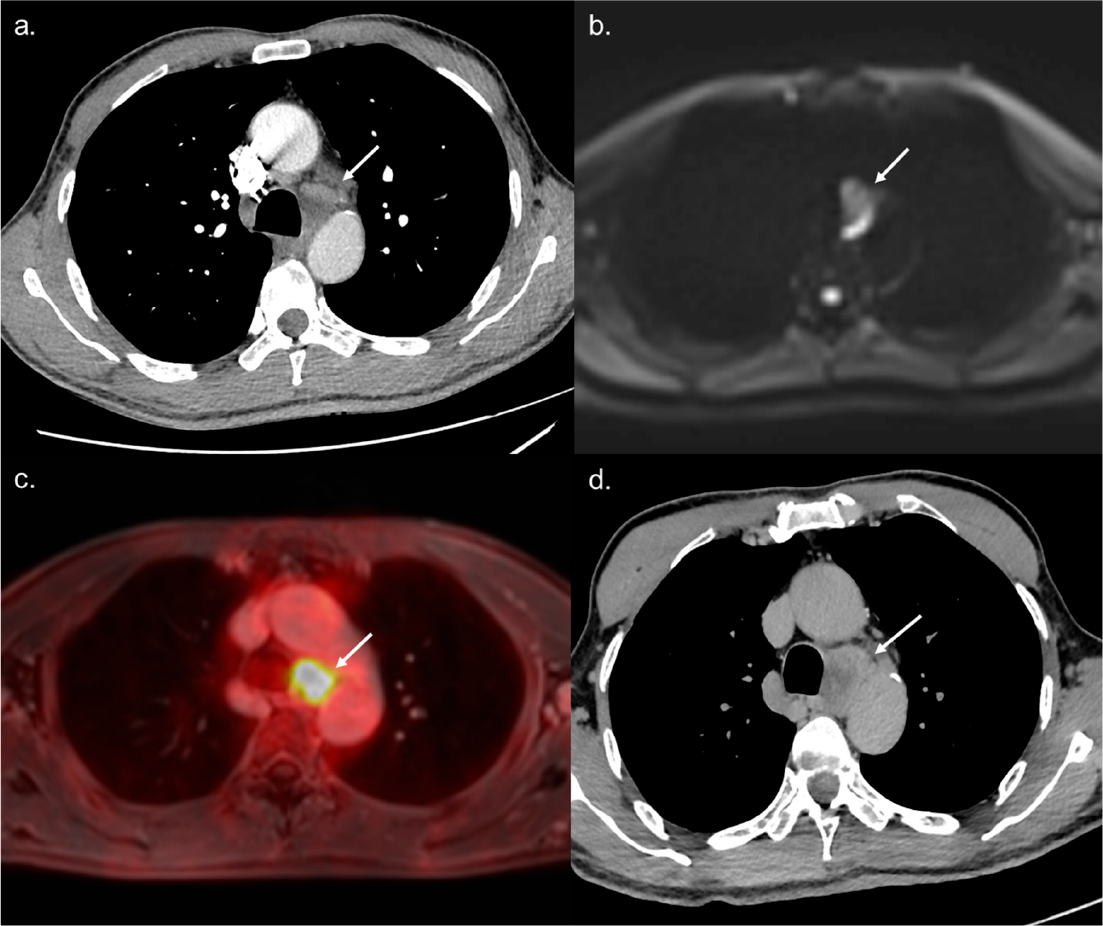
Figure 4. A 68-year-old BCLC C patient referred to WB-PET/MRI before TARE. The CT-CAP performed ( a ) showed a 12 × 25 mm large mediastinal lymph node of indeterminate nature. The WB-PET/MRI revealed hyperintensity on b800 s/mm² DWI ( b ) with hypermetabolism on 18 F-FDG-PET ( c ) suggestive of metastatic involvement. Followup performed two months later confirmed the metastatic nature of the lymph nodes with rapid increase in size and necrosis ( d ).